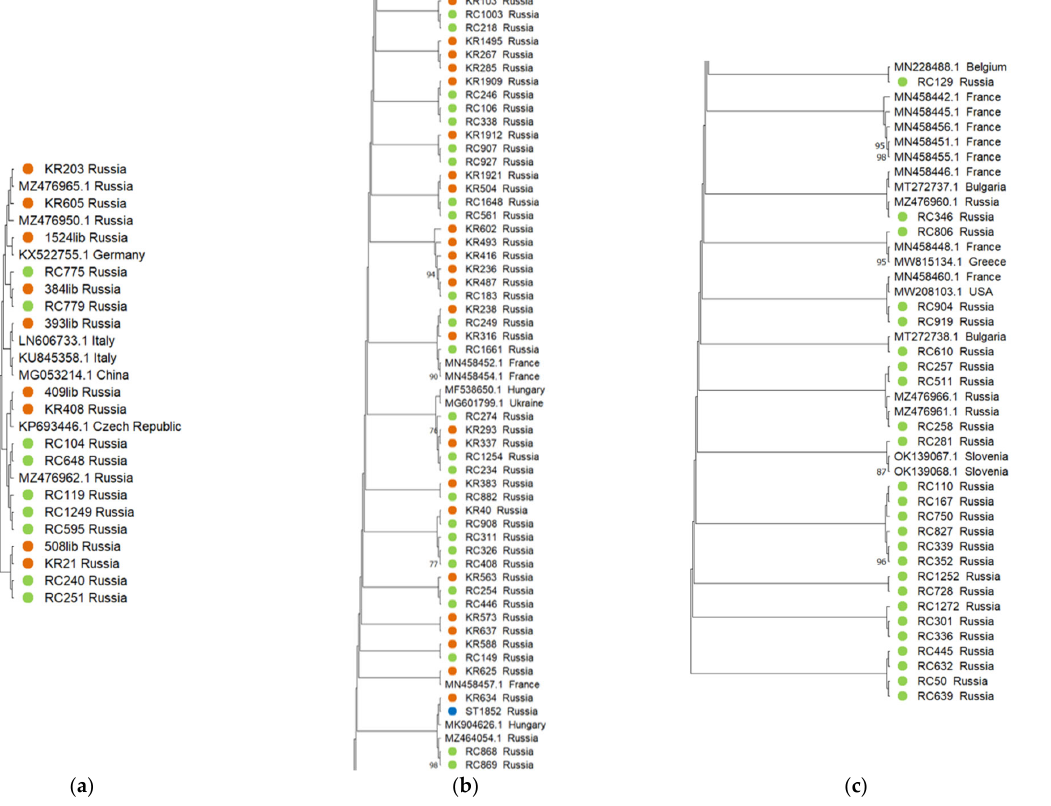
Figure 2. Phylogenetic analysis of global isolates of GPGV based on nucleotide sequences of the movement protein (MP) and coat protein (CP) genes. Russian isolates from the Krasnodar Krai, Stavropol Krai, and Republic of Crimea are marked in orange, blue, and green, respectively. The main clades with the largest number of Russian isolates are shown in ( a – c ). The tree was constructed using the maximum likelihood method. The numbers at the nodes indicate bootstrap support (1000 replicates); values above 60% are shown. Branches corresponding to partitions reproduced in less than 50% of the bootstrap replicates are collapsed.